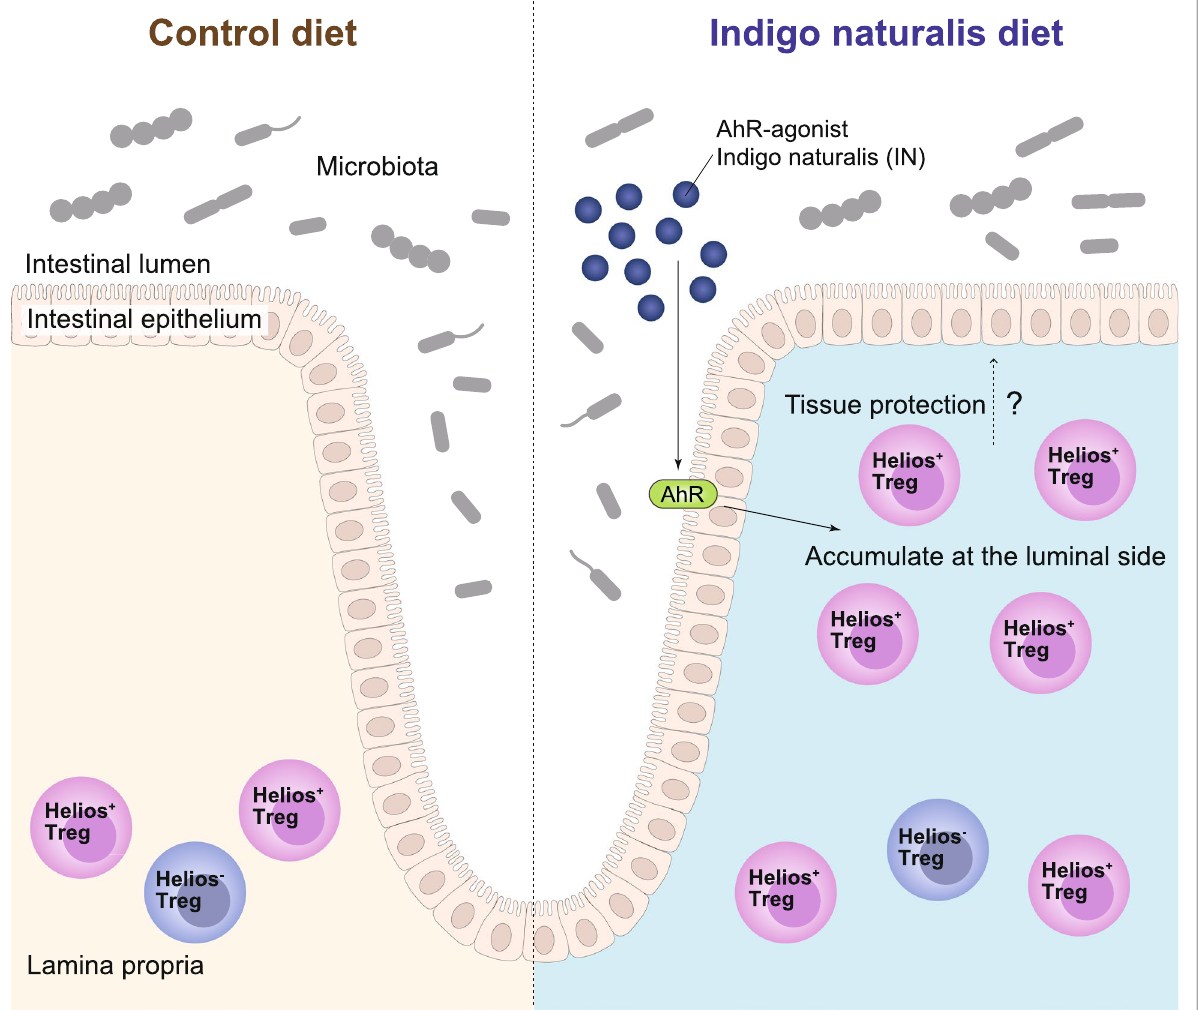
Fig. 4 Treg location in steady-state and AHR-ligand diet